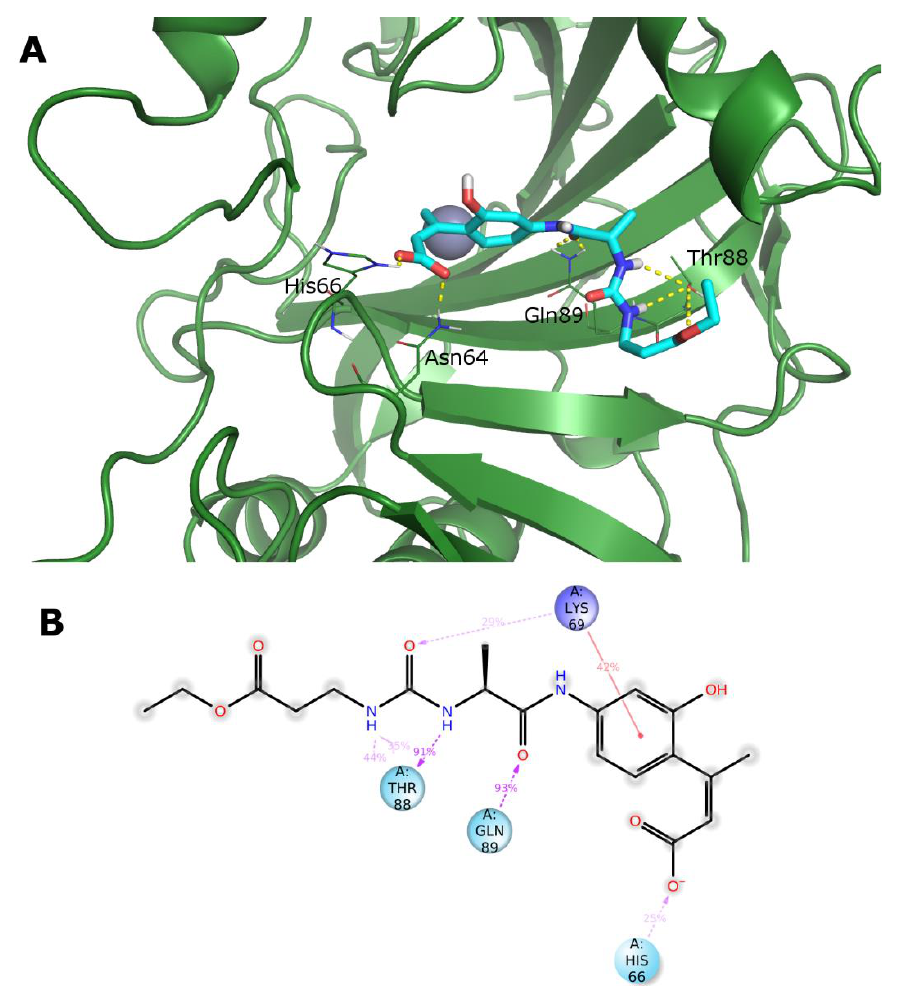
Figure 4. ( A ) Depiction of the binding geometry explored by ligand 19 in a representative frame of the MD simulation. ( B ) 2D representation of most conserved ligand-protein interactions with an indication of the persistence (%) along the simulation.